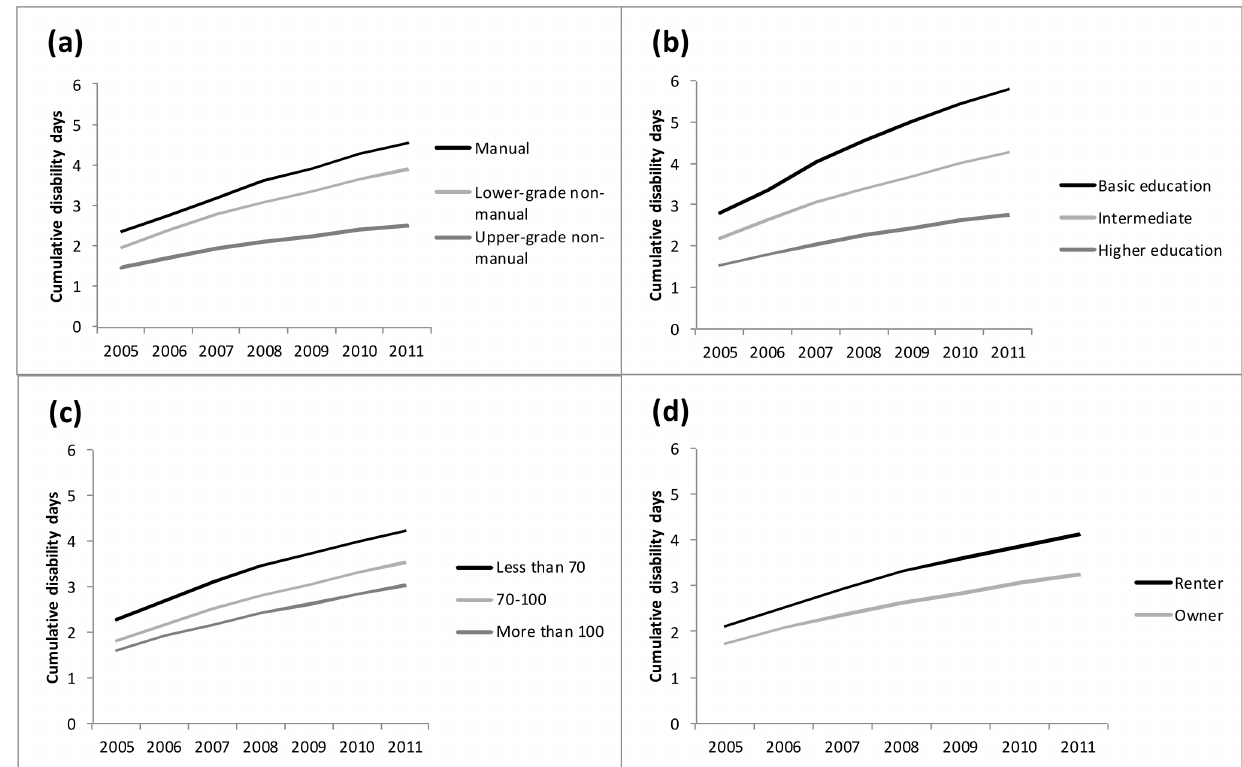
Figure 1. Cumulative disability days due to depression per cumulative person-years by indicators of socioeconomic status: (a) occupational position (b) level of education (c) residence size, m 2 (d) residence ownership.